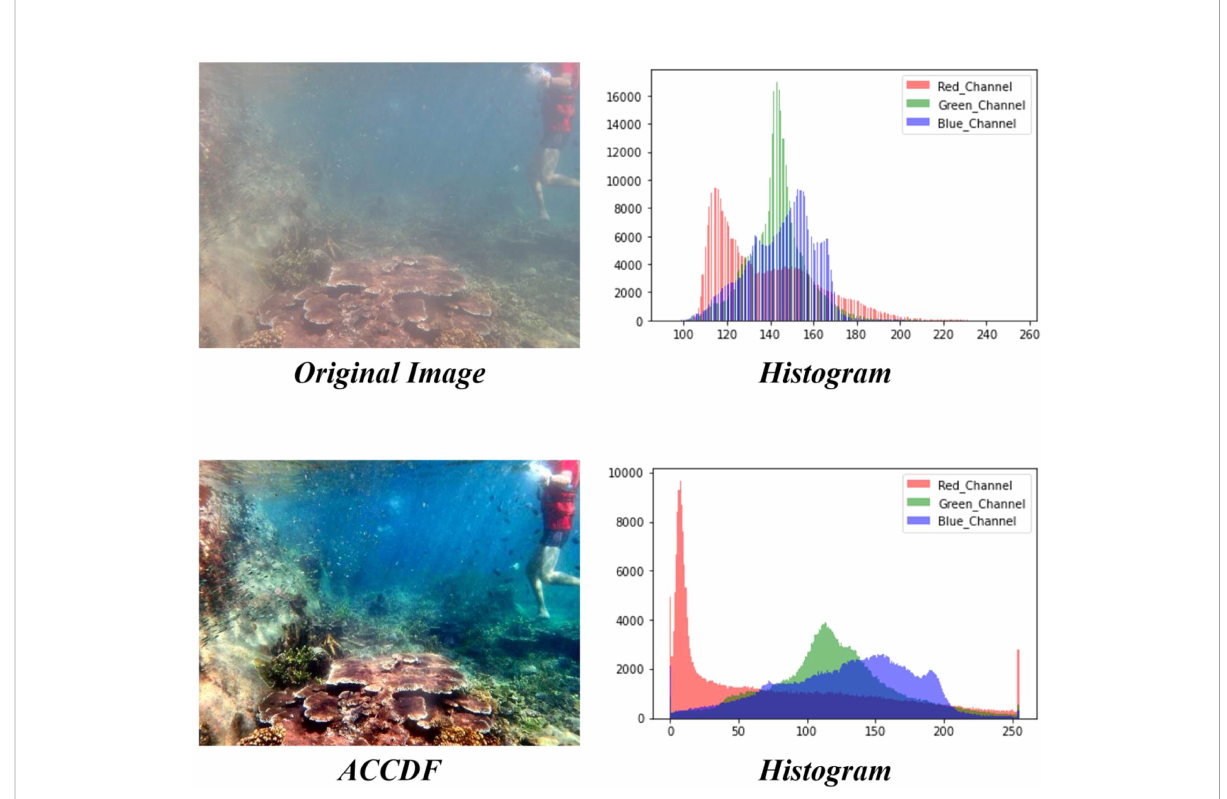
FIGURE 13 Histogram comparison of Figure